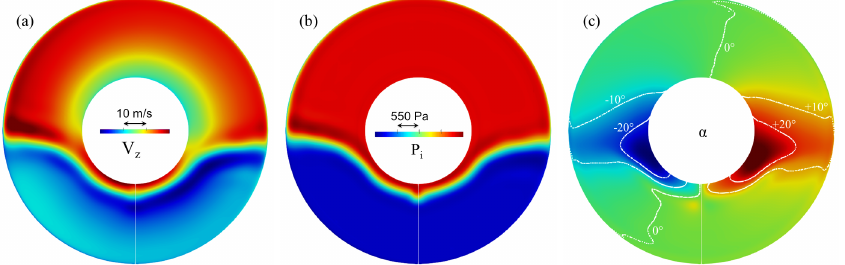
Figure 8. ( a – c ) Boundary conditions used in PC model for the compressor operating point ( T i is uniform).